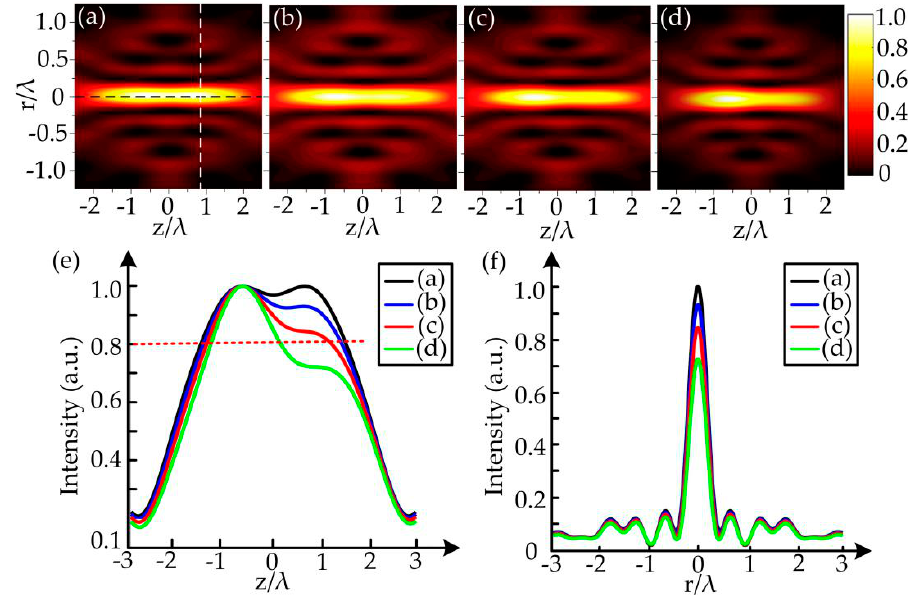
Figure 4. Creation of the movable super-diffraction optical needle (MSON) at different oblique incidence angles. Contours of | E | 2 in the r -z plane when oblique incident angles are ( a ) 0 ◦ , ( b ) 10 ◦ , ( c ) 15 ◦ , and ( d ) 20 ◦ . ( e ) and ( f ) are the depth of focus (DOF) and full width at half-maximum (FWHM) of the MSON when the oblique incidence angles are ( a ) 0 ◦ , ( b ) 10 ◦ , ( c ) 15 ◦ , and ( d ) 20 ◦ . The intensity distribution at the longitudinal plane, as marked by the black dashed line in ( a ), is plotted in ( e ). The intensity distribution at the transverse plane, as marked by the white dashed line in ( a ), is plotted in ( f ).